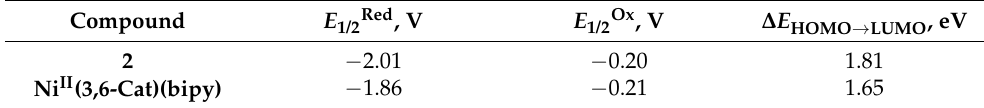
Table 4. The comparison of CV data for complex 2 and Ni II (3,6-Cat)(bipy) . Compound E 1/2Red , V E 1/2Ox , V